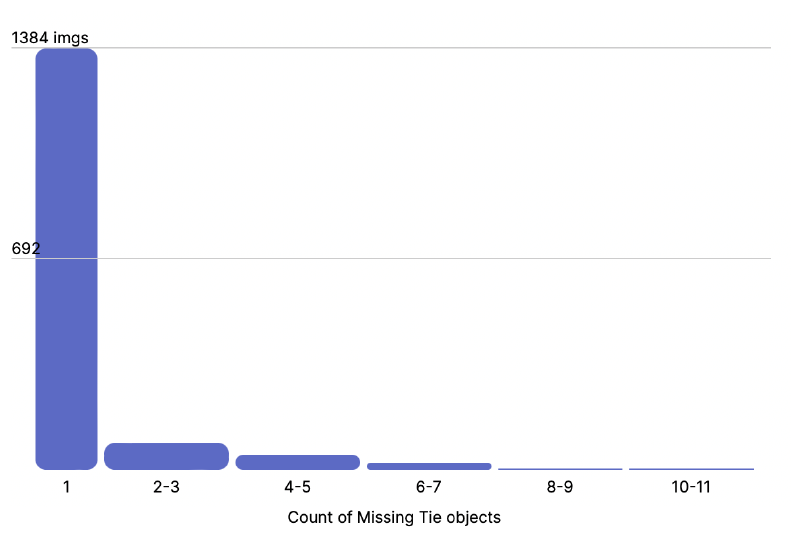
Figure 14. Distribution of missing tie objects per